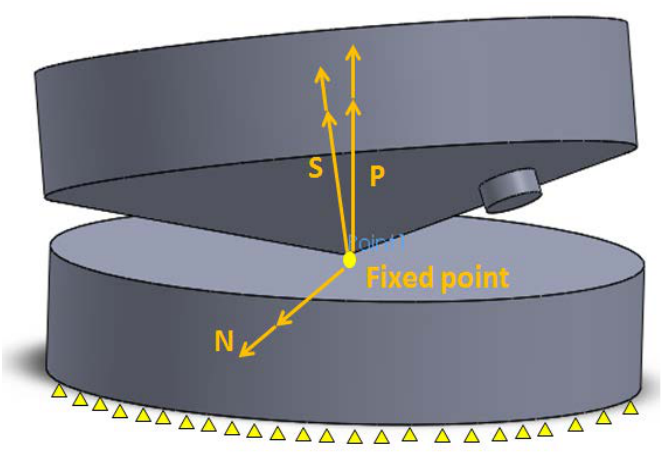
Figure 10: Boundary condition of the rotary hammer